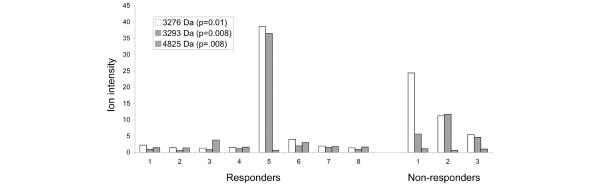
Serum proteins in SJIA patients according to whether they responded to conventional therapy. Three most significant differences distinguishing between pretreatment samples from conventional therapy responders (n = 8) and those from nonresponders (n = 3), suggesting a profile predictive of response to conventional therapy. The averaged peak intensity is shown for the eight pretreatment 'responder' patient samples (left panel) compared with the corresponding intensities of those same three peaks from the three pretreatment 'nonresponder' patient samples (right panel). SJIA, systemic-onset juvenile idiopathic arthritis.